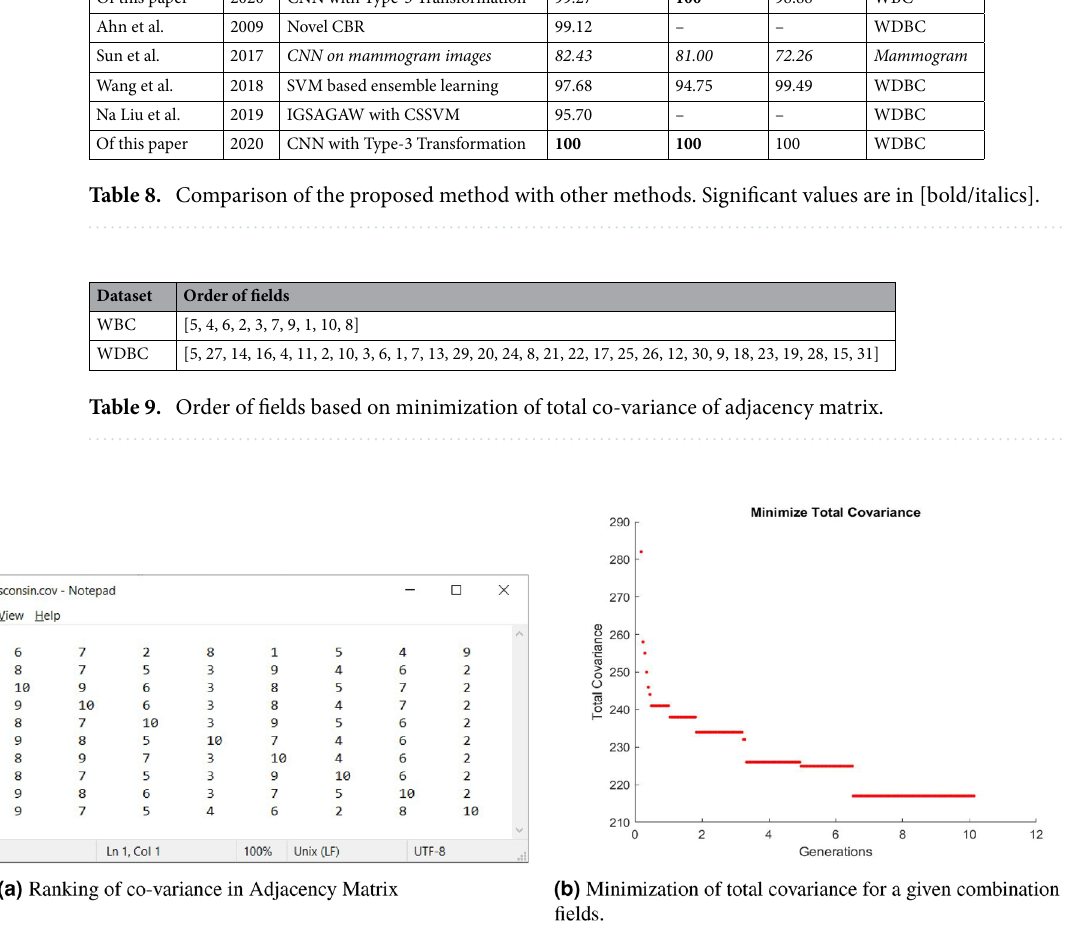
Figure 6. Minimization of covariance for WBC